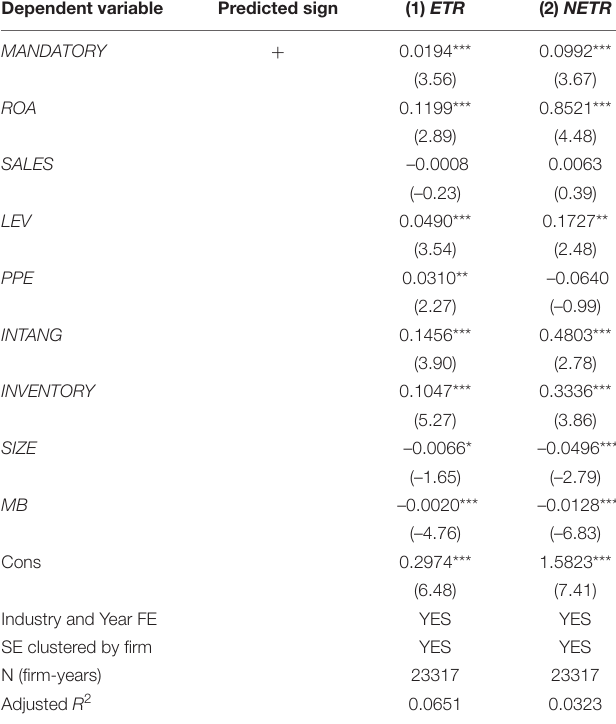
TABLE 2 | Test of